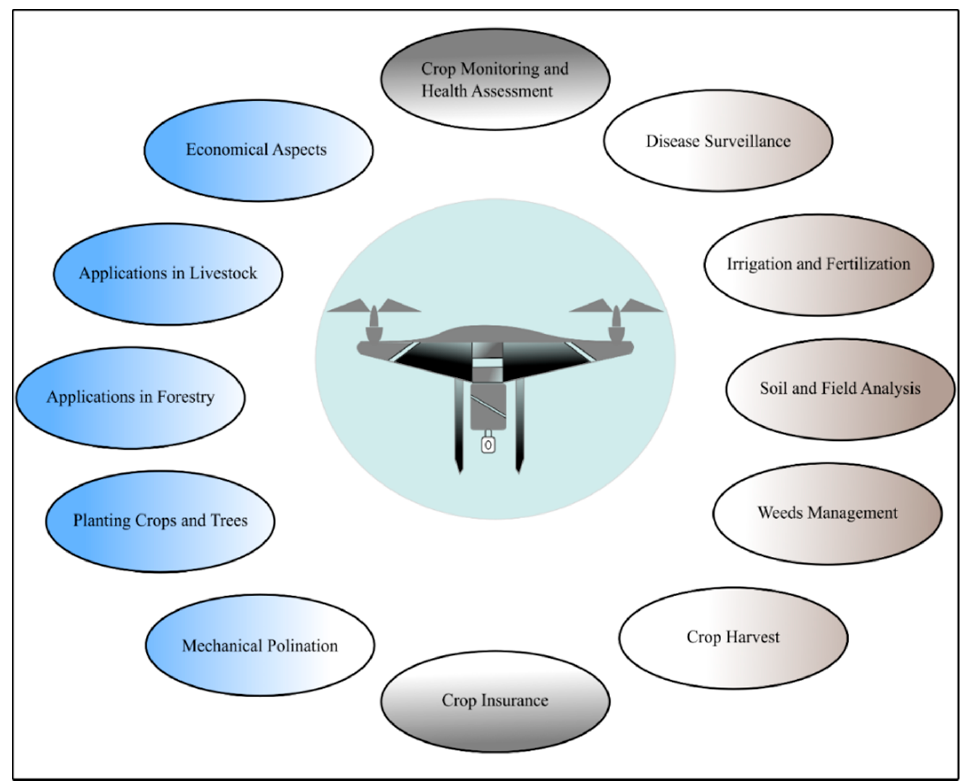
Figure 5. A schematic diagram of RPA application in agriculture.